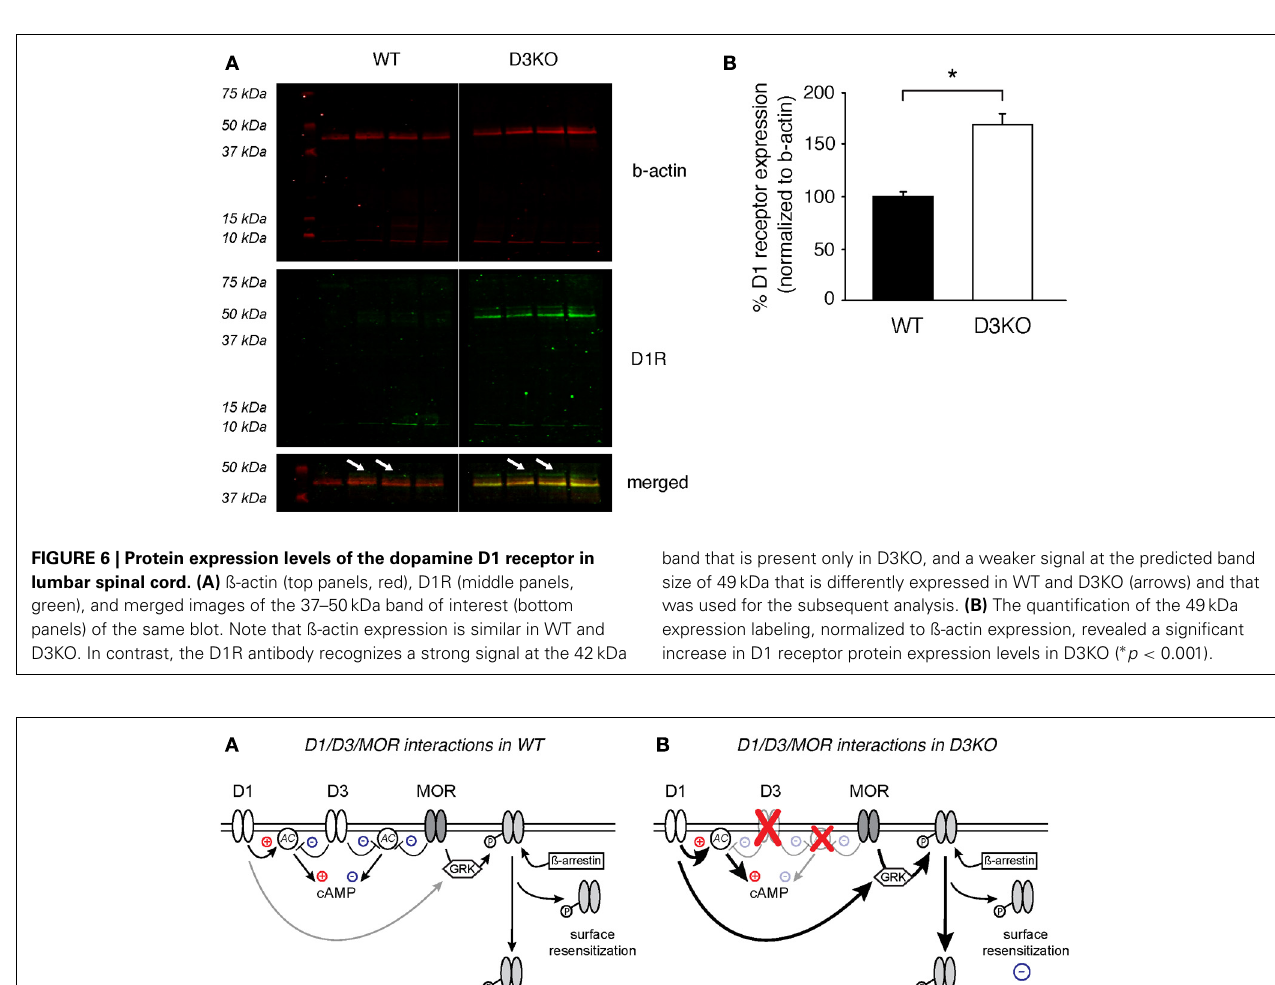
FIGURE 7 | Proposed model of D1 and D3 receptor interactions with MOR in WT (A) and D3KO (B). (A) Naïve WT with intact D1, D3, and MOR signaling pathways. (B) D3KO with compromised D3 function and altered second messenger cascades.